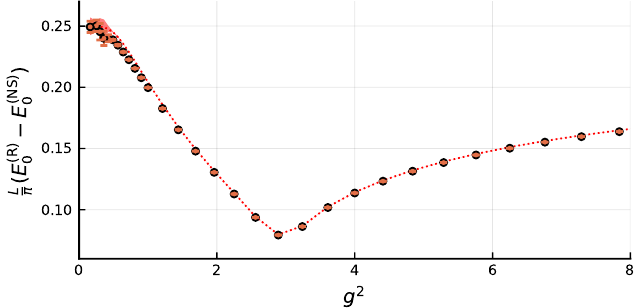
Figure 7 . The gap between the two ground states of the modular Hamiltonian as a function of the squared coupling. The dotted line represents the CFT prediction from eq. (7.11), where L was eliminated using eq. (7.10), so that no free parameters remain. The error bars and shaded area correspond to uncertainties in the extrapolated entanglement eigenvalues.